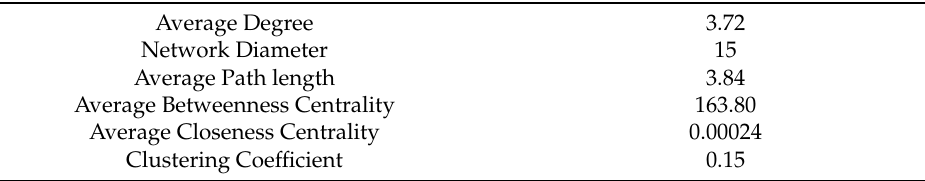
Table 3. Metrics of the package dependency network.